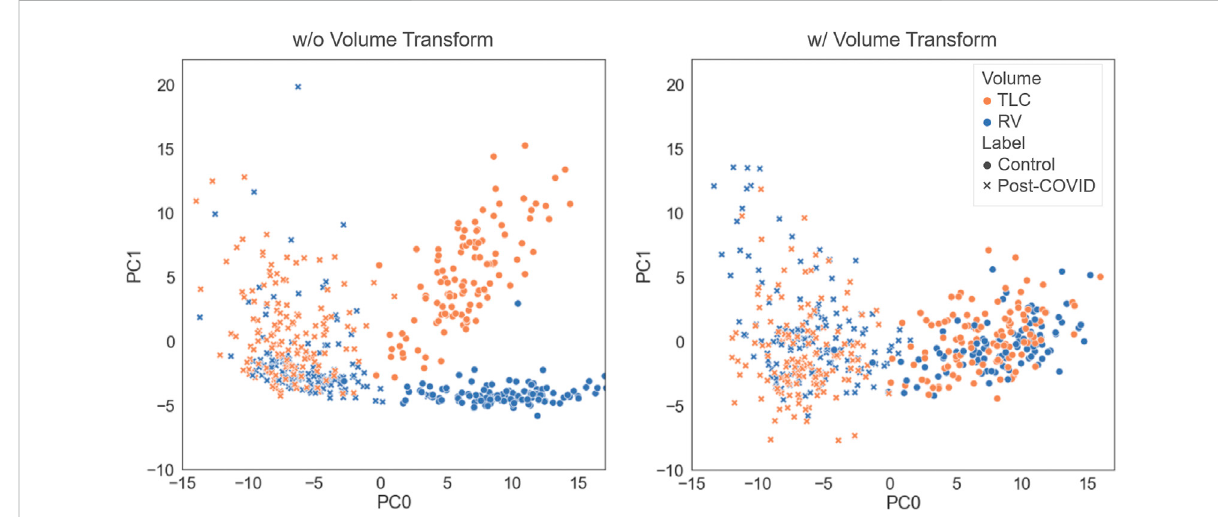
FIGURE 2 Comparison of the latent representations generated by the models trained with and without the volume transform. The data points were projected on the fi rst and second principal axes.